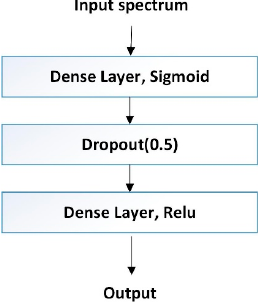
Figure 5. Schematic showing the back-propagation algorithm architecture used for comparison in this study. It consists of one input layer, one output layer, two hidden layers and one dropout layer.